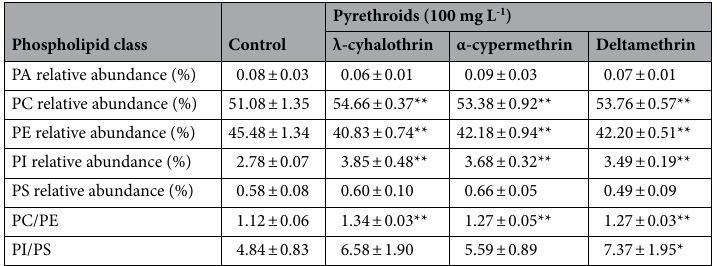
Table 3. Phospholipid composition and PC/PE and PI/PS ratios determined in the B. bassiana cells after 48 h of cultivation with λ-cyhalothrin, α-cypermethrin, and deltamethrin. Data are means ± SD; all samples were prepared in triplicate, and the experiments were repeated twice. Results were tested by one-way ANOVA; significance: ** P < 0.01, * P < 0.05.